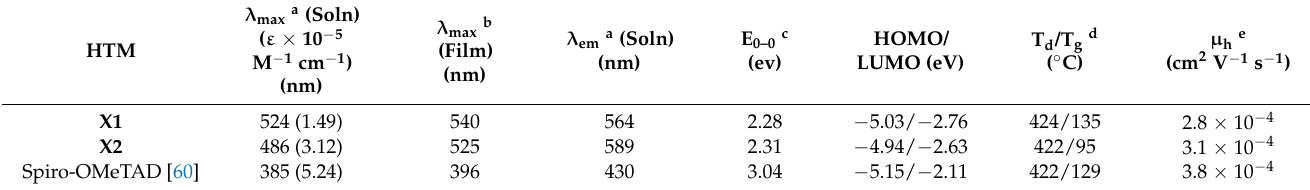
Table 1. Optical, cyclic-voltammetry, thermal, hole-mobility properties of X1 , X2 ,